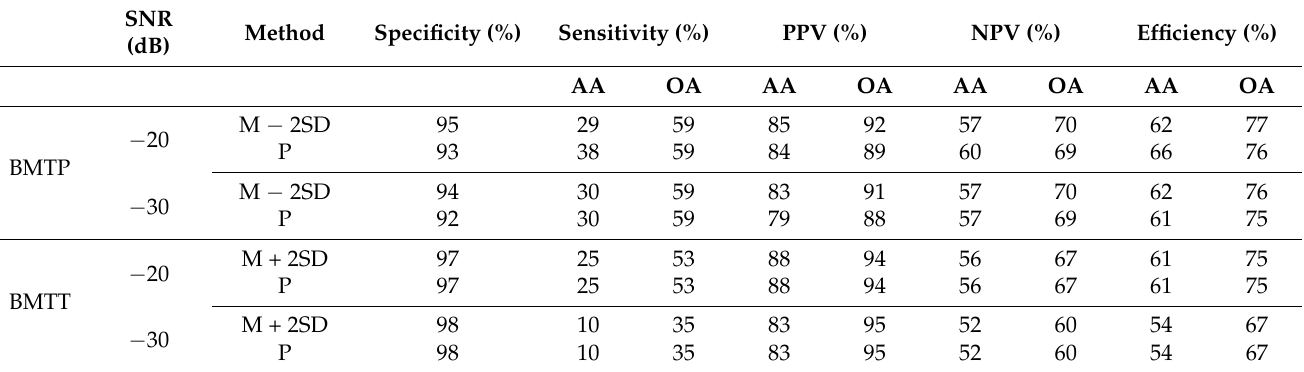
Table 3. Indices (%) of specificity, sensitivity, efficiency, positive, and negative predictive values of the backward masking test (BMT) for each testing condition, method of calculation, and compari- son group.